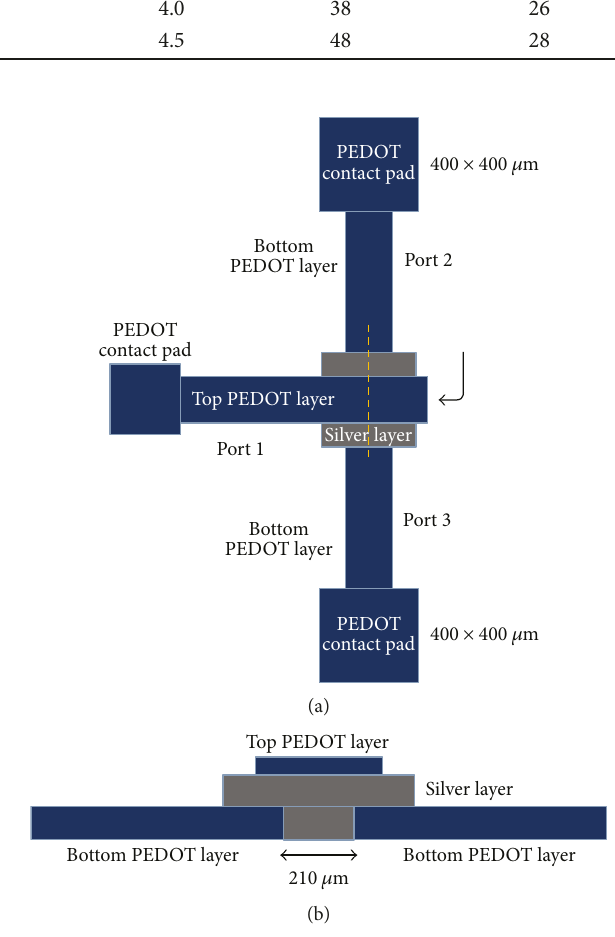
Figure 2: Schematic (a) top view and (b) cross-sectional view of the designed MEMS switch along the dashed line